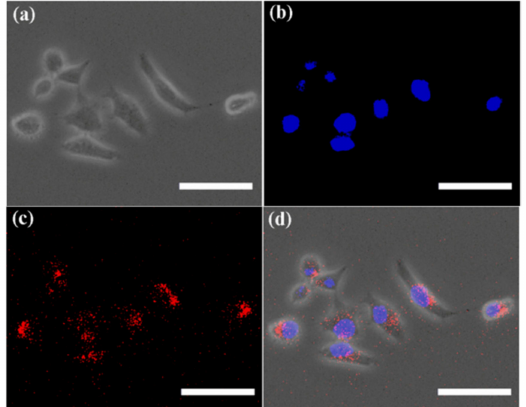
Figure 6. Confocal Laser Microscopy images of cancer cells co-cultured with sodium heparin coated Eu 3+ HAP. ( a ) bright field; ( b ) blue: cell nuclei ( c ) red fluorescence observed in the cytoplasm of cells around cell nuclei, demonstrating the feasibility of SH-Eu:nHAP as bioimaging agent; ( d ) merged image. Scale bars are 50 µ m. With permission from Elsevier. https://doi.org/10.1016/j.colcom.2019 .01.001 (accessed on 19 May